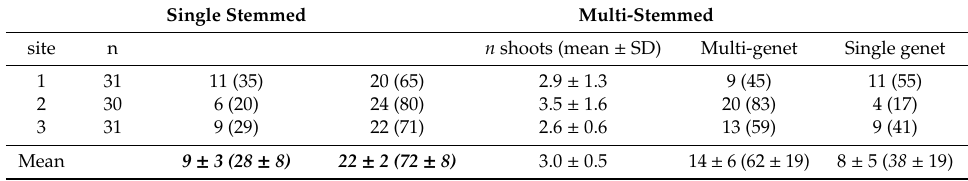
Table 1. Number of P. cembra individuals at a wind-exposed ridge above treeline belonging to single- or multi-stemmed growth form. Multi-stemmed growth form is divided into multi-genet individuals developing from seed caches, and single-genet individuals, which developed upright growing lower branches. Percentages are given in parenthesis. For multi-stemmed growth form the mean number of shoots ± standard deviation per site are given. Significant di ff erences ( p < 0.05) in the mean values of the three plots ( ± SD) between single- and multi-stemmed and between multi-genet and single genet, respectively, are marked in bold and italics. Single